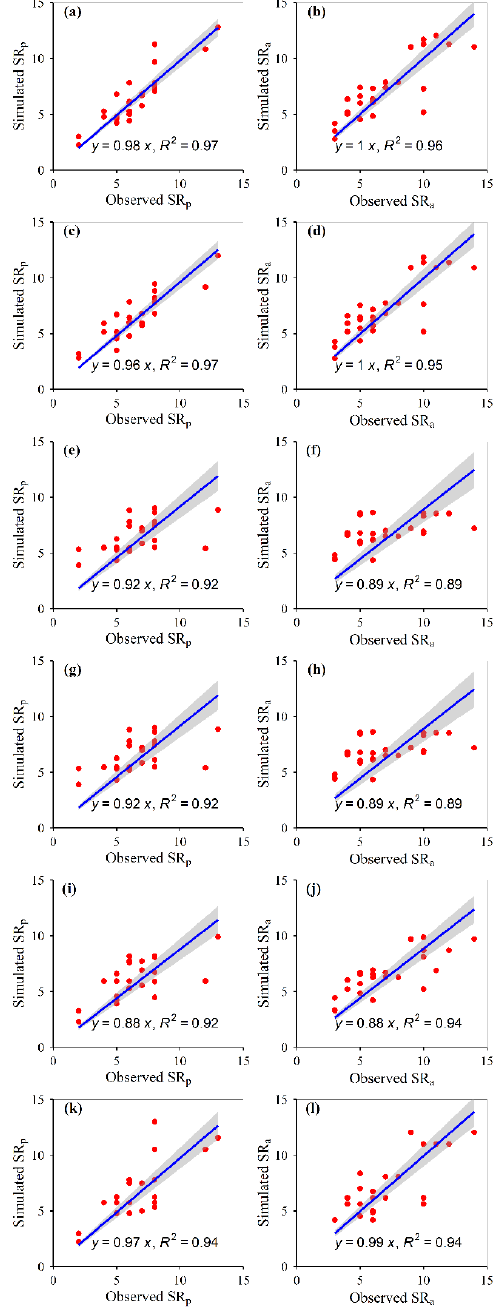
Figure 2. Correlations between the simulated and observed species richness of the plant community under fencing ( a , c , e , g , i , k ) and grazing ( b , d , f , h , j , l ) scenes, for random forest ( a , b ), generalized boosted regression ( c , d ), artificial neural network ( e , f ), multiple linear regression ( g , h ), support vector ma- chines ( i , j ) and recursive regression trees ( k , l ). The solid lines indicate the linear fitted lines between the simulated and observed species richness. SR p : potential species richness; SR a : actual species richness. All the regressions were significant at p <